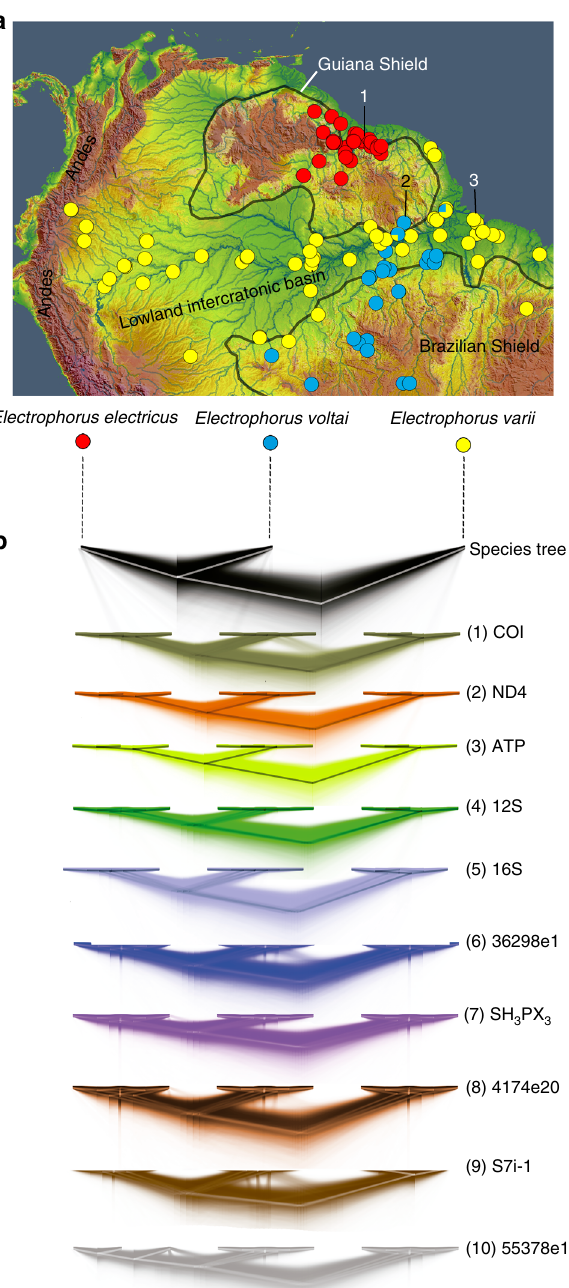
Fig. 1 Sampling localities and gene trees for the three species of Electrophorus